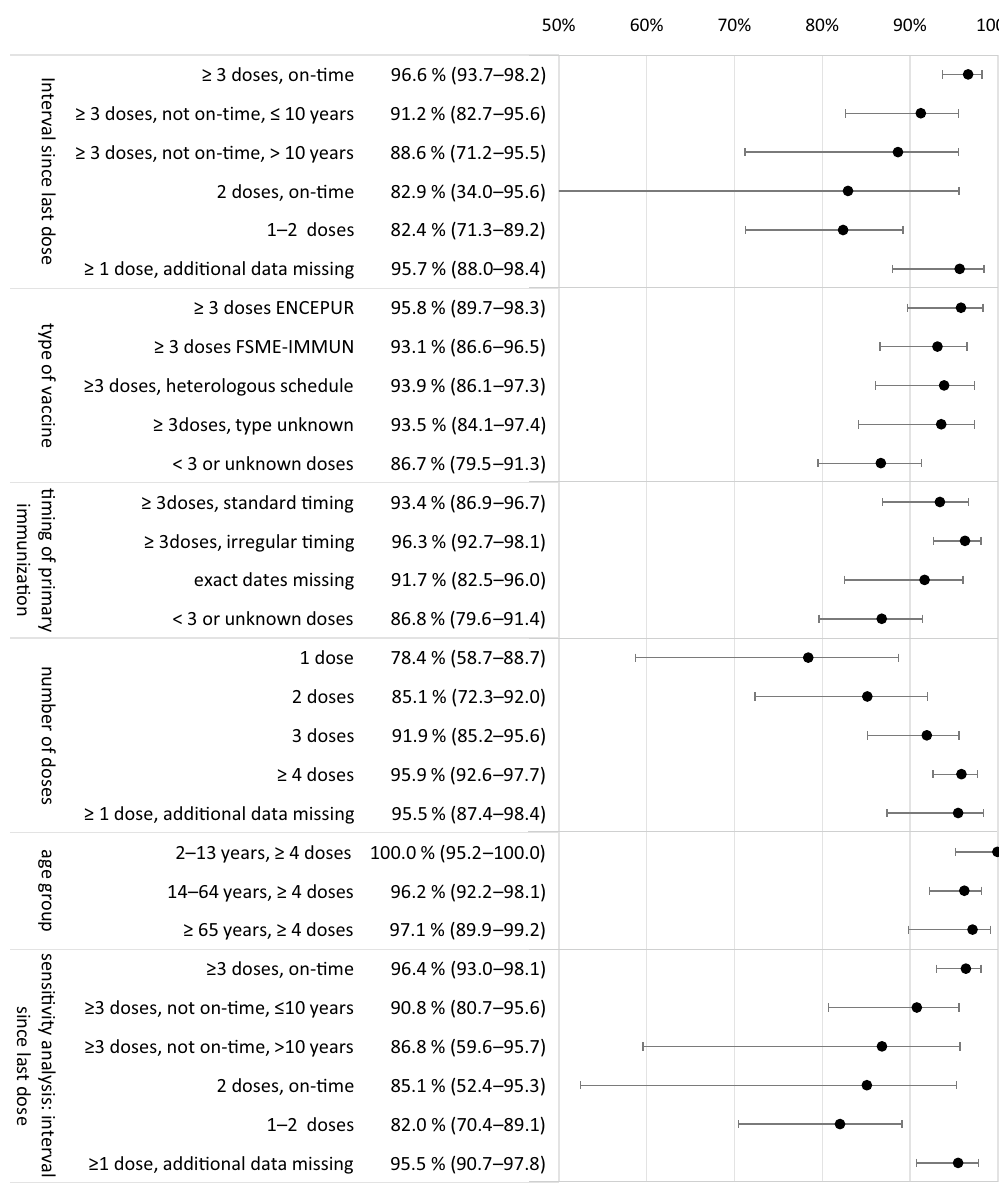
Figure 2. TBE vaccine effectiveness determined by time intervals since last dose, type of vaccine, timing of the first 3 doses, age group, and number of doses, ( n = 570 TBE cases, 964 controls). The lower section shows a sensitivity analysis of the time interval analysis only using exact dates (no imputation, see “Methods”). Estimates represent the adjusted total causal effect for each TBE vaccination covariate on the outcome TBE. The minimal adjustment set consisted of: matching factors (age, sex, region), dog ownership, tick bites, risk behaviours (taking walks, gardening, other outdoor activities, not staying on paths) during 4-week periods of exposure time (cases) or reference time (controls), season, and rural residence (Supplementary Fig. 2). For univariable estimates and case numbers in each category, see Supplementary Table 1. CI confidence interval, VE vaccine effectiveness.